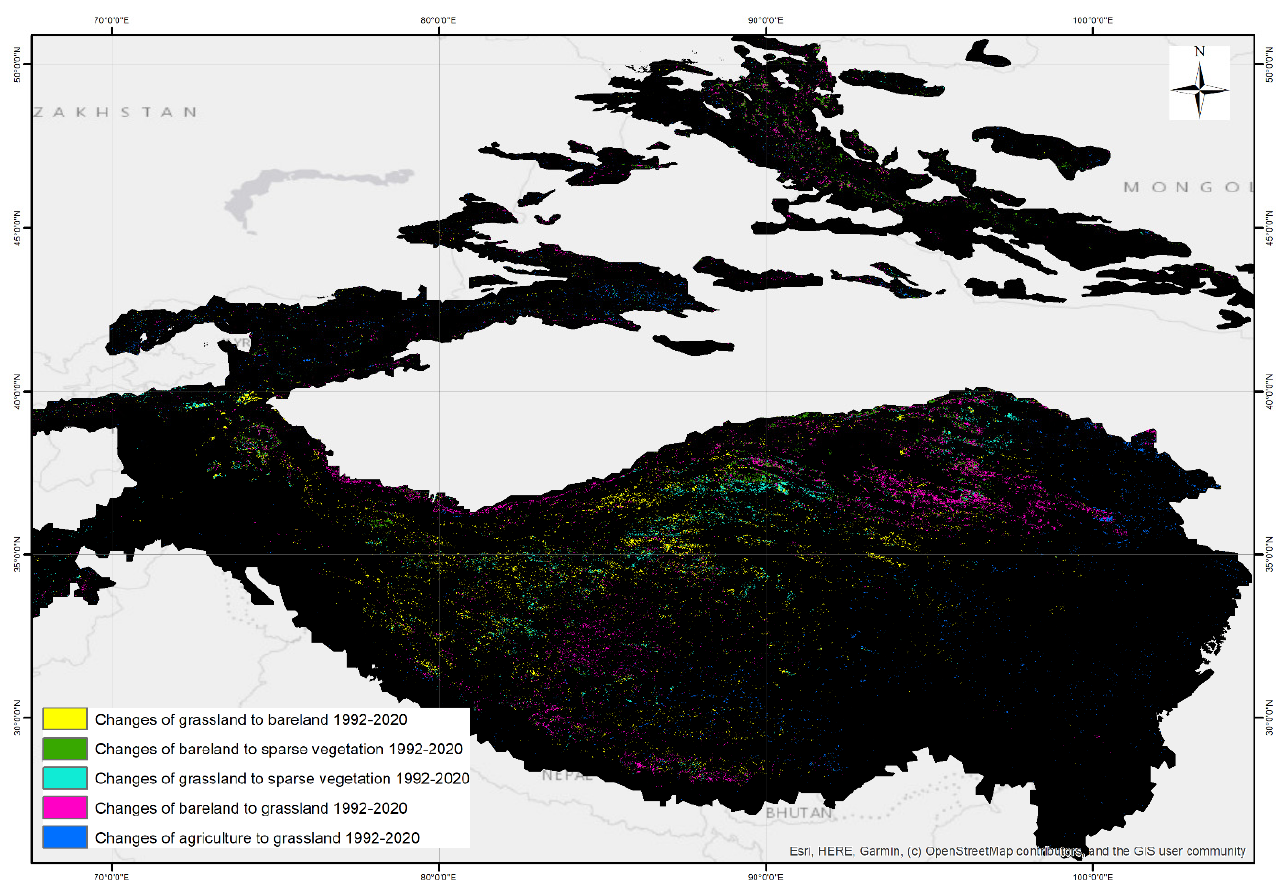
Figure 5. A map showing the Third Pole’s main transferred land-cover trends between 1992 and